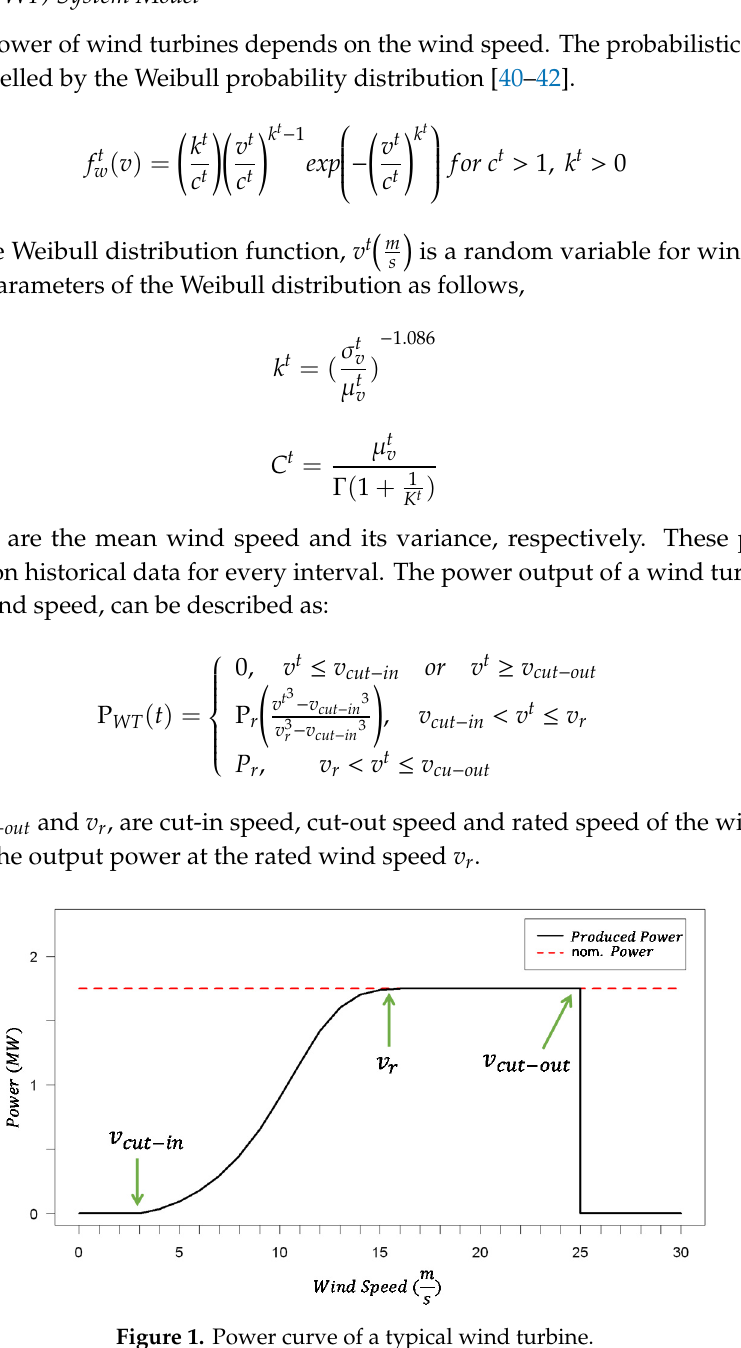
Figure 1. Power curve of a typical wind turbine.